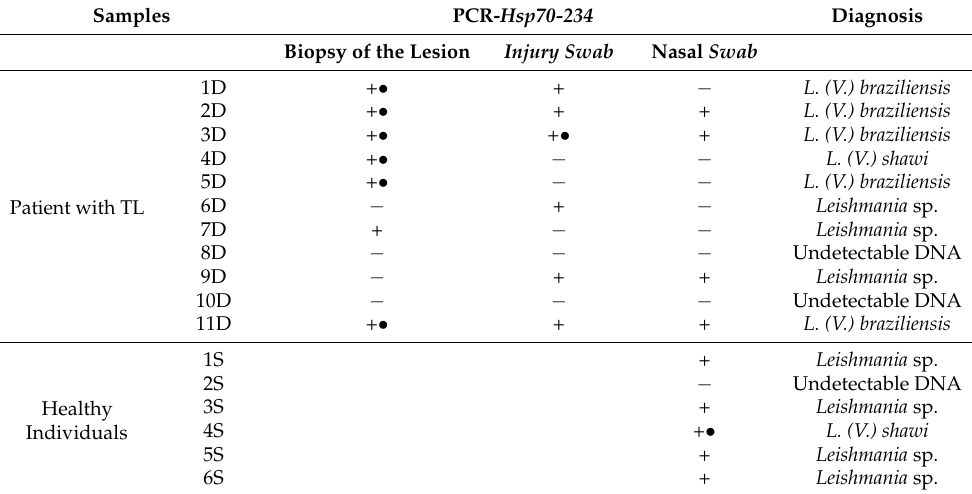
Table 1. TL in an endemic area of the Amazon: etiology of Leishmania sp. infection in individuals from the city of Tom é -Açu, in northeastern Par á , Brazil. (+) Amplified DNA; ( − ) Unamplified DNA; ( • ) DNA sequenced.